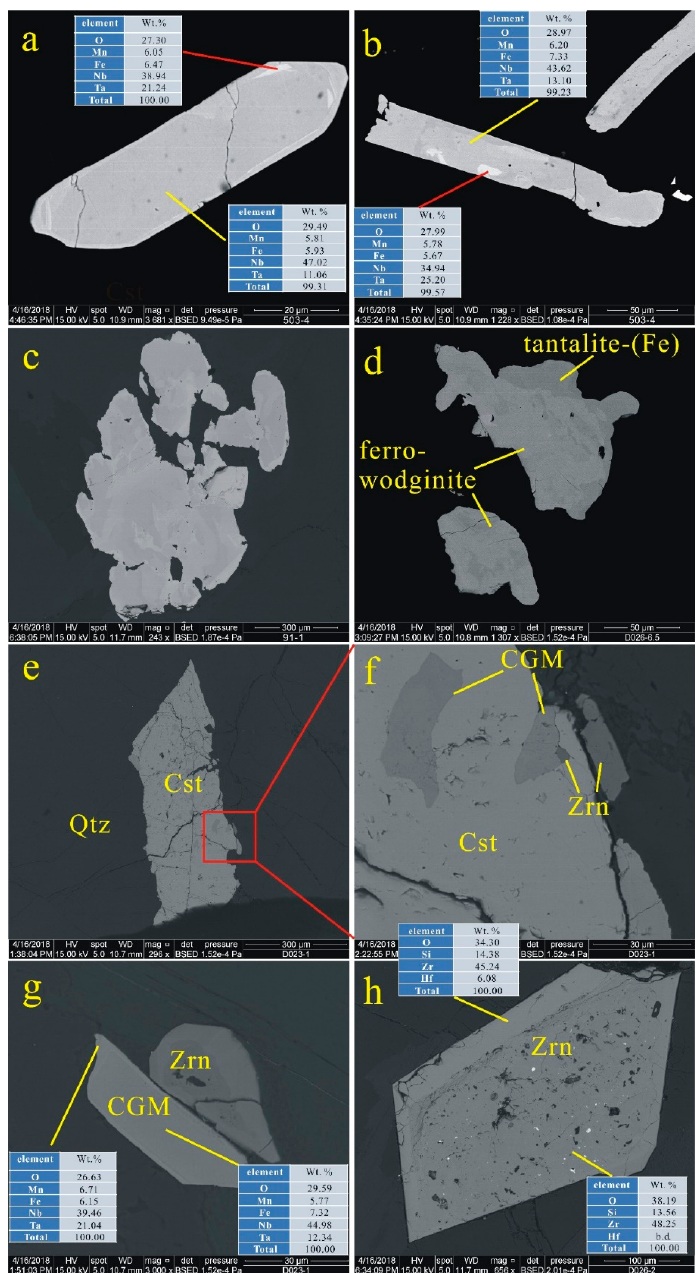
Figure 5. Back scattered electron (BSE) images of CGM, cassiterite and zircon in the Dahongliutan pegmatites. ( a ) euheral CGM (Type 2) showing sector zoning and increased Ta concentration from core to rim. ( b ) euhedral CGM (Type 2) showing distorted oscillatory zoning and patchy pattern. The bright phase contains much higher Ta than grey phases in the CGM. ( c ) anhedral CGM aggregate (Type 3) showing a patchy zoning with the Ta-Fe-rich domains (the brighter phase) at the margin of the crystal or along factures. ( d ) anhedral tantalite-(Fe)-ferrowodginite intergrowths only spotted in the Wall Zone of No. 90 pegmatite. ( e , f ) showing subhedral cassiterite containing CGM inclusions (Type 1) and zircon. The CGM inclusions show no orientation. ( f ) is the enlargement of the red box in ( e ). ( g ) euhedral CGM associated with coeval zircon. ( h ) euhedral zircon crystal in the Wall Zone of No. 90 pegmatite exhibiting a porous core (caused by dissolution-reprecipitation) and a relatively clean rim. Abbreviations: Qtz = quartz, Cst = cassiterite, CGM = columbite-group minerals, and Zrn =